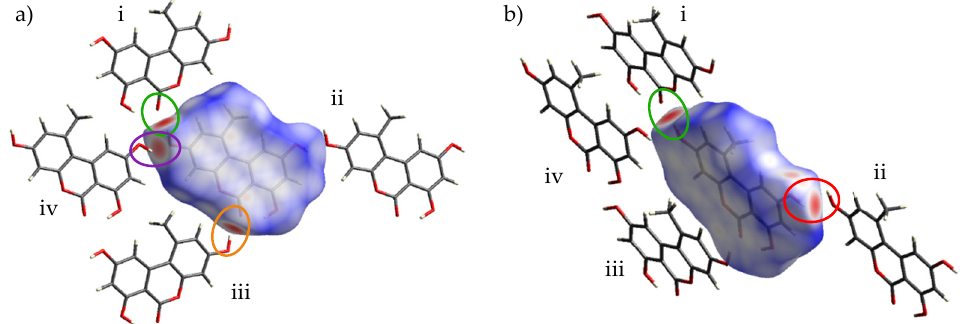
Figure 7. Hirshfeld surface of Form II mapped over d norm along with external molecules i–iv: a perpendicular view of the molecule and its surface ( a ) and an angled view ( b ). Red regions on the surface represent close contacts, blue regions represent long contacts, and white regions represent contacts in which the distance is equal to the van der Waals radii.